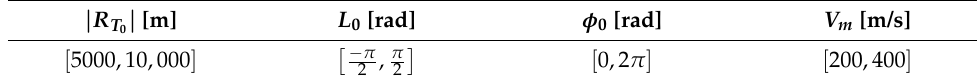
Figure 2. Geometry of the planar environment. Table 1. Target position and missile speed for scenario A.